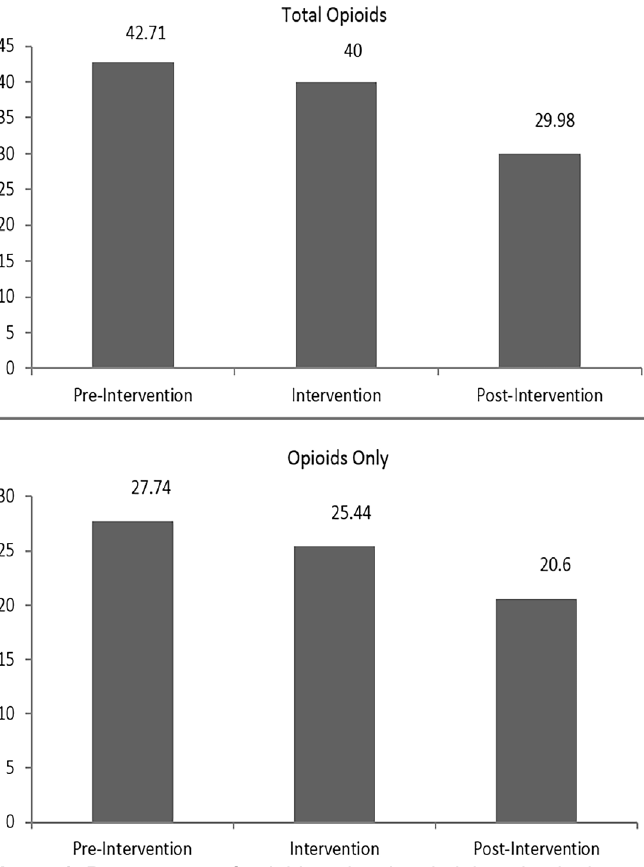
Figure 2 . Percentages of opioid analgesic prescribed at